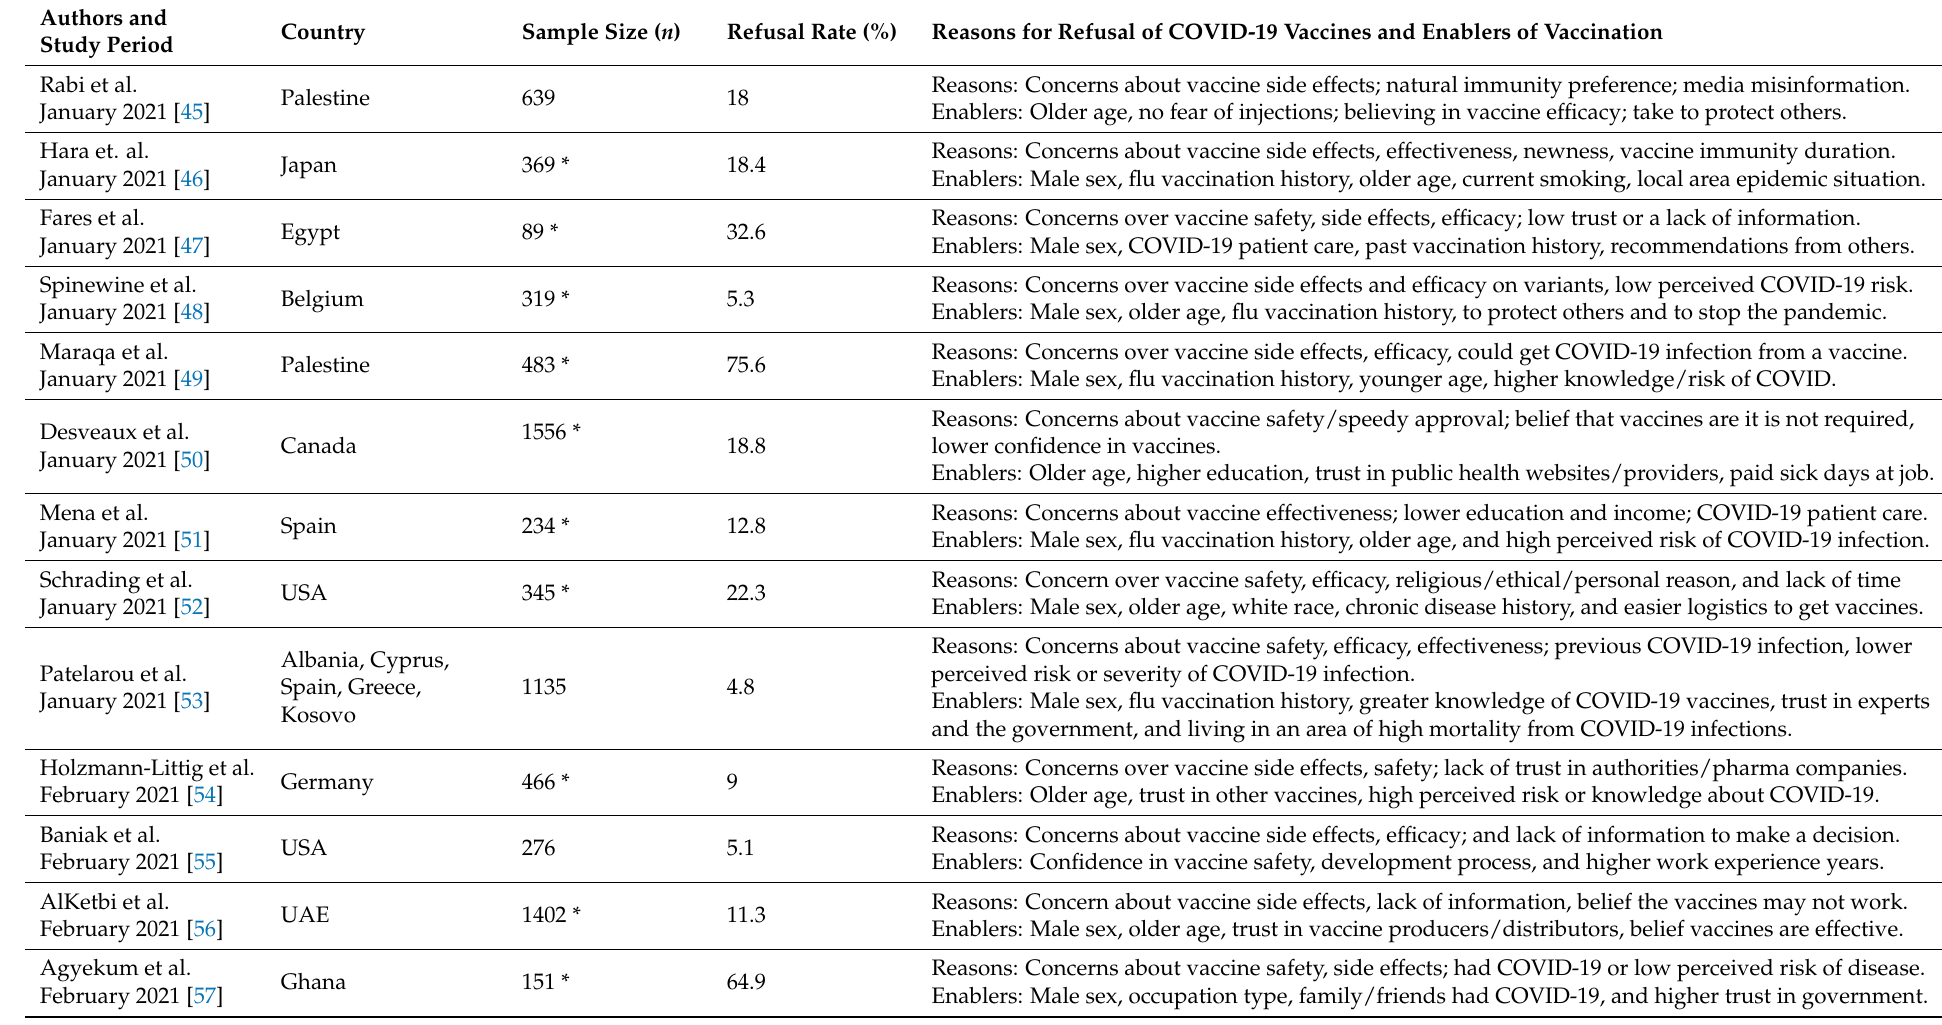
Table 2. COVID-19 Vaccination Refusal Rates and Reasons Among Nurses (January 2021–May